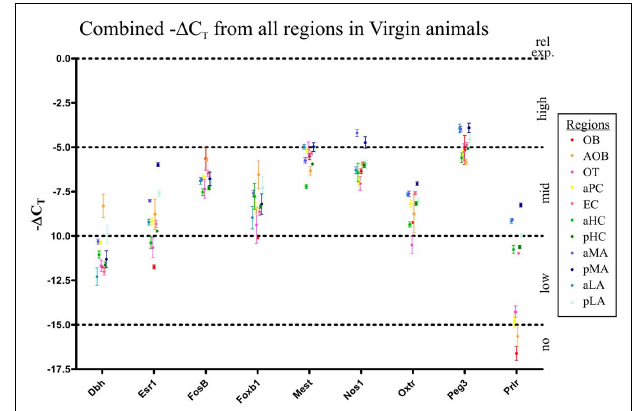
FIGURE 2 | Relative gene expression levels in virgin mice of the nine genes of interest in the 11 olfactory brain regions. Gene expression was normalized against housekeeping gene expression (Gapdh) to determine the (cid:2) C T value (i.e., PCR cycle at which gene was detected above threshold).The earlier a gene is detected, the lower its (cid:2) C T value and the higher the level of expression.To graph this, we plot the − (cid:2) C T value, for easier interpretation: physically higher points on the graph represent higher gene expression. Gene expression from all 11 gene regions examined were plotted ( − (cid:2) C T ± SD) to compare expression between genes. All nine genes were found in all 11 regions, although relative levels of expression differed. Interestingly, only Prlr showed a largely dichotomy in expression between regions, with seven the regions (pMA, aMA, pLA, aLA, aHC, pHC, and EC) having significantly higher expression than the other four regions (OB, AOB, aPC, and OT). All other genes generally had between two-fold and eight-fold variation in expression between regions (i.e., (cid:2) C T values within two to four